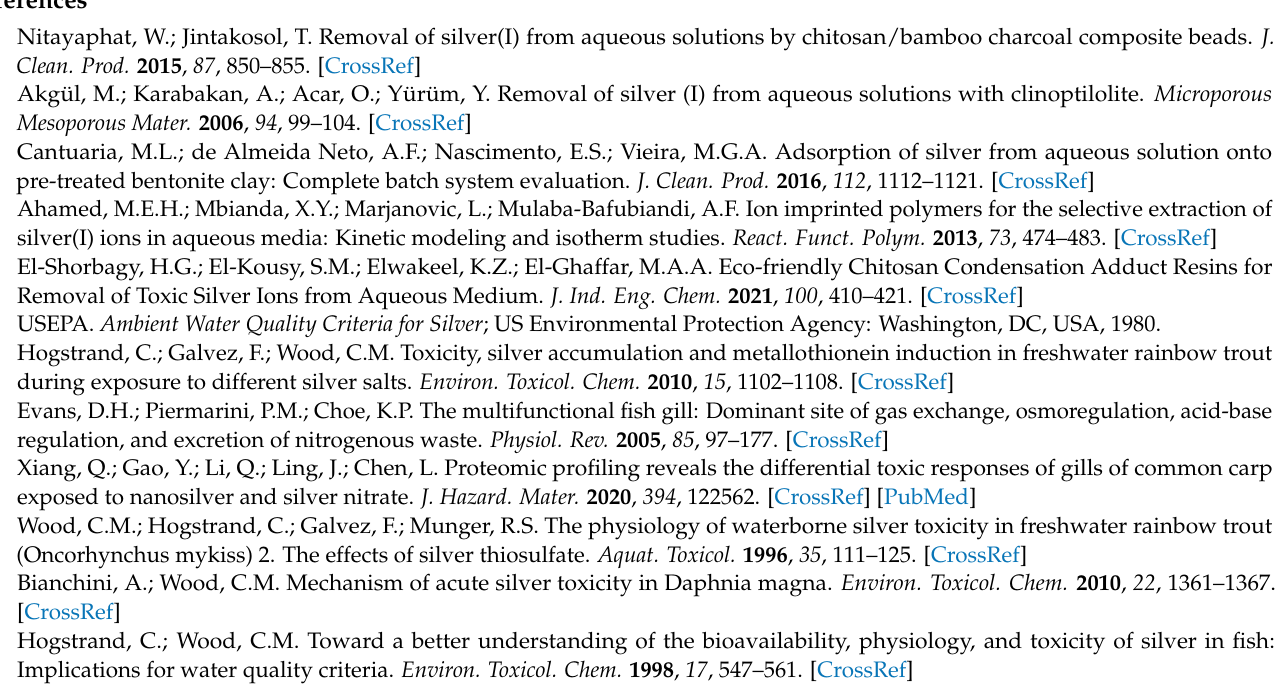
Table S1. The ATVs of silver to freshwater aquatic organisms in China. Table S2. The CTVs of silver to freshwater aquatic organisms in China. Table S3. The individual species slopes and the K pooled calculated for the ATVs vs. hardness relationship for silver. Table S4. The fitting evaluation results of the SSD models for